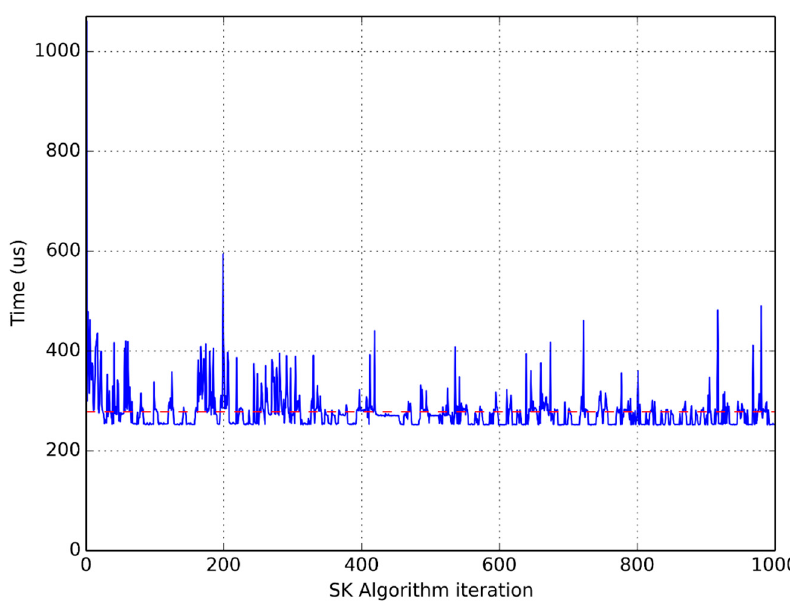
Figure 7. Elapsed time to calculate each iteration. i7-3517U.